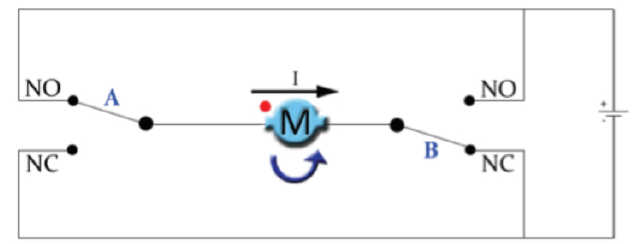
Figure 5. Inverted polarity circuit.